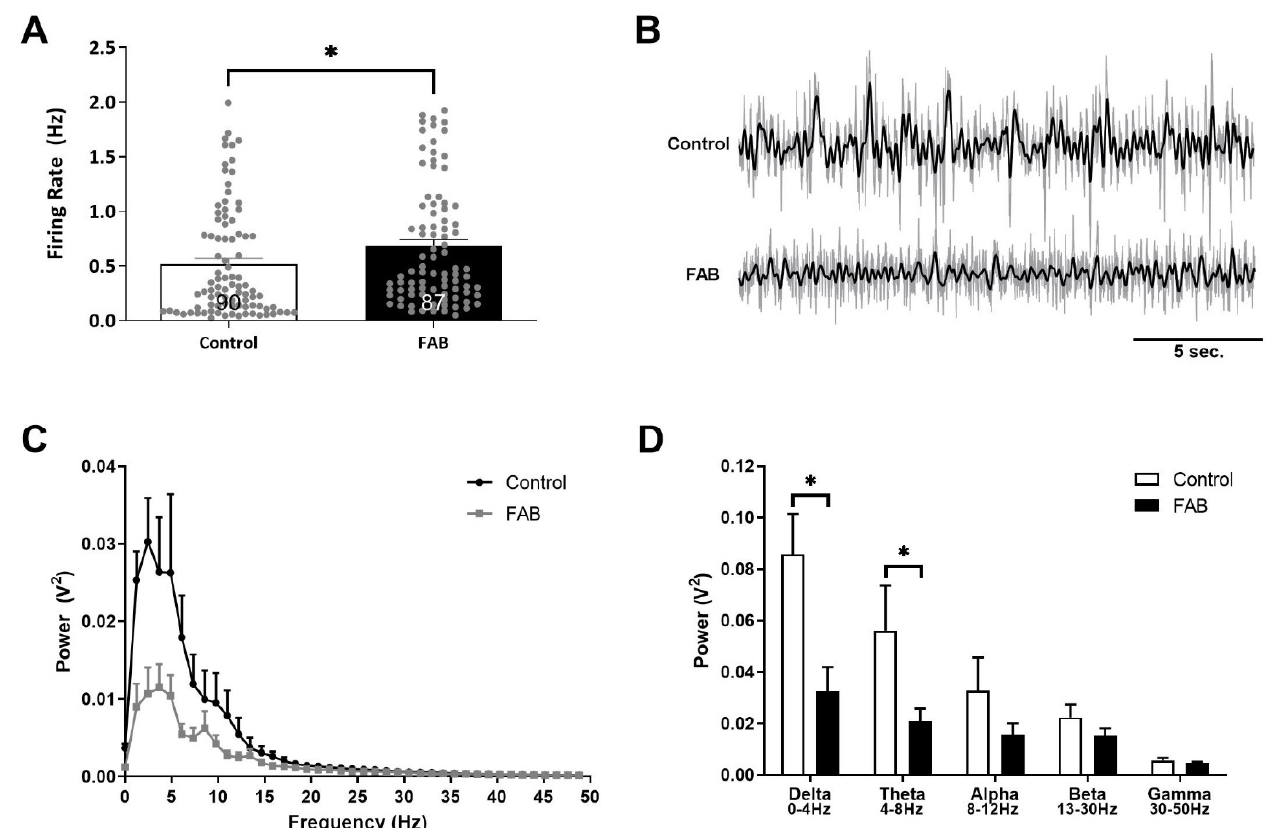
Figure 1. The average firing rate of spontaneously active putative pyramidal neurons in the ventral hippocampus (vHipp) was significantly higher in FAB rats, indicative of regional hyperactivity ( A ). Representative trace of spontaneous local field potential oscillations (filtered for <4 Hz; dark line) throughout the vHipp of a control (top) and FAB (bottom) rat ( B ). FAB rats displayed significant decreases in power in lower-frequency oscillations ( C ), specifically in the delta and theta frequency bands, as summarized in ( D ). * p < 0.05.